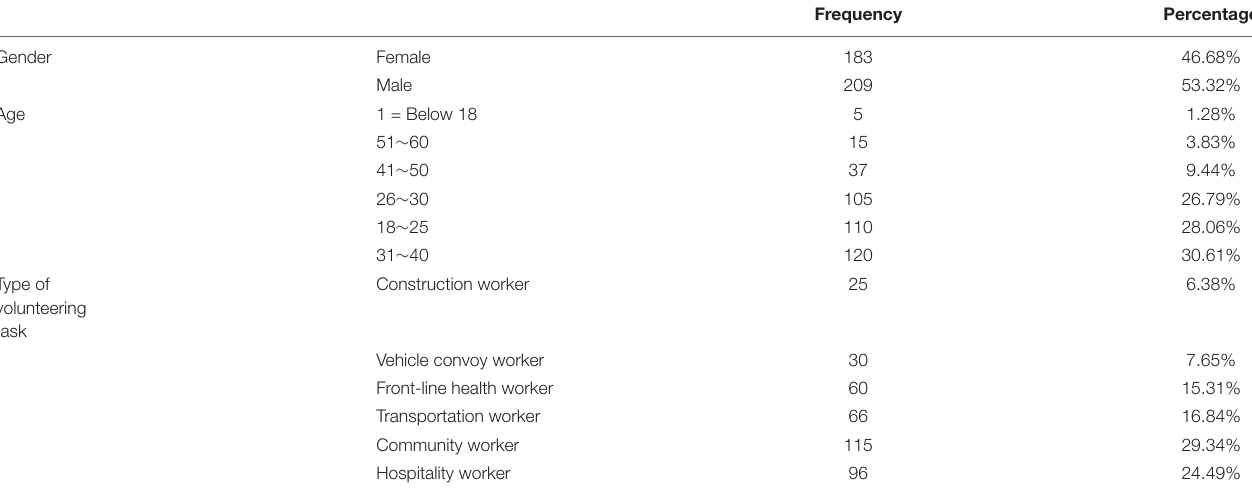
TABLE 3 | Descriptive statistics of study 2 ( N =